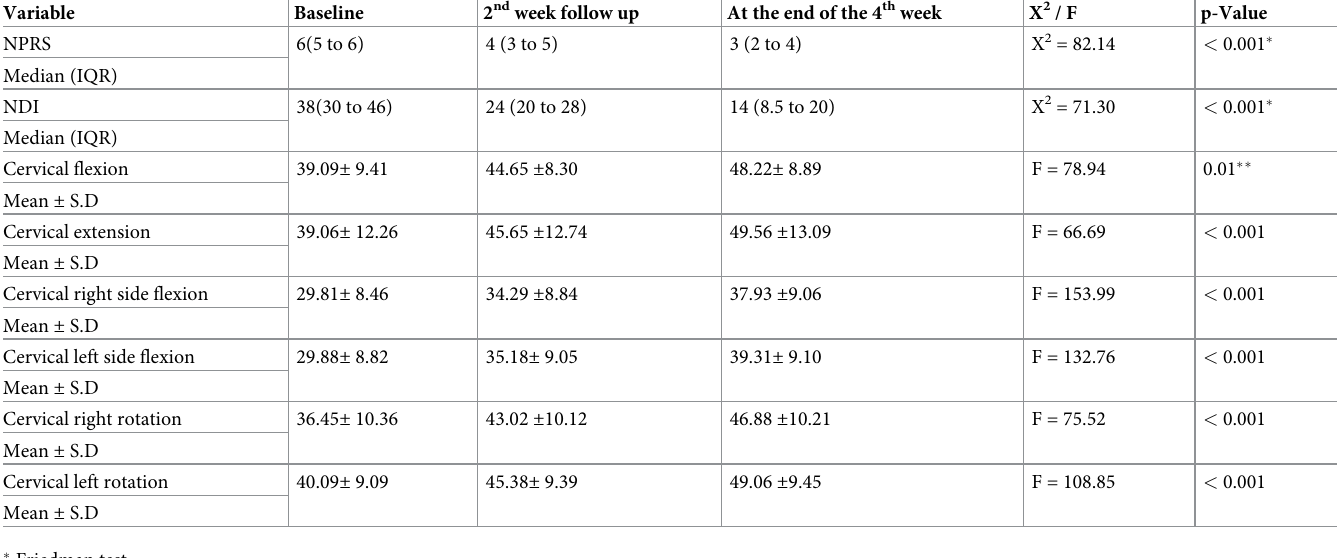
Table 3. Comparison of pain (NPRS), disability (NDI), and cervical mobility (ROM) within the experimental group.